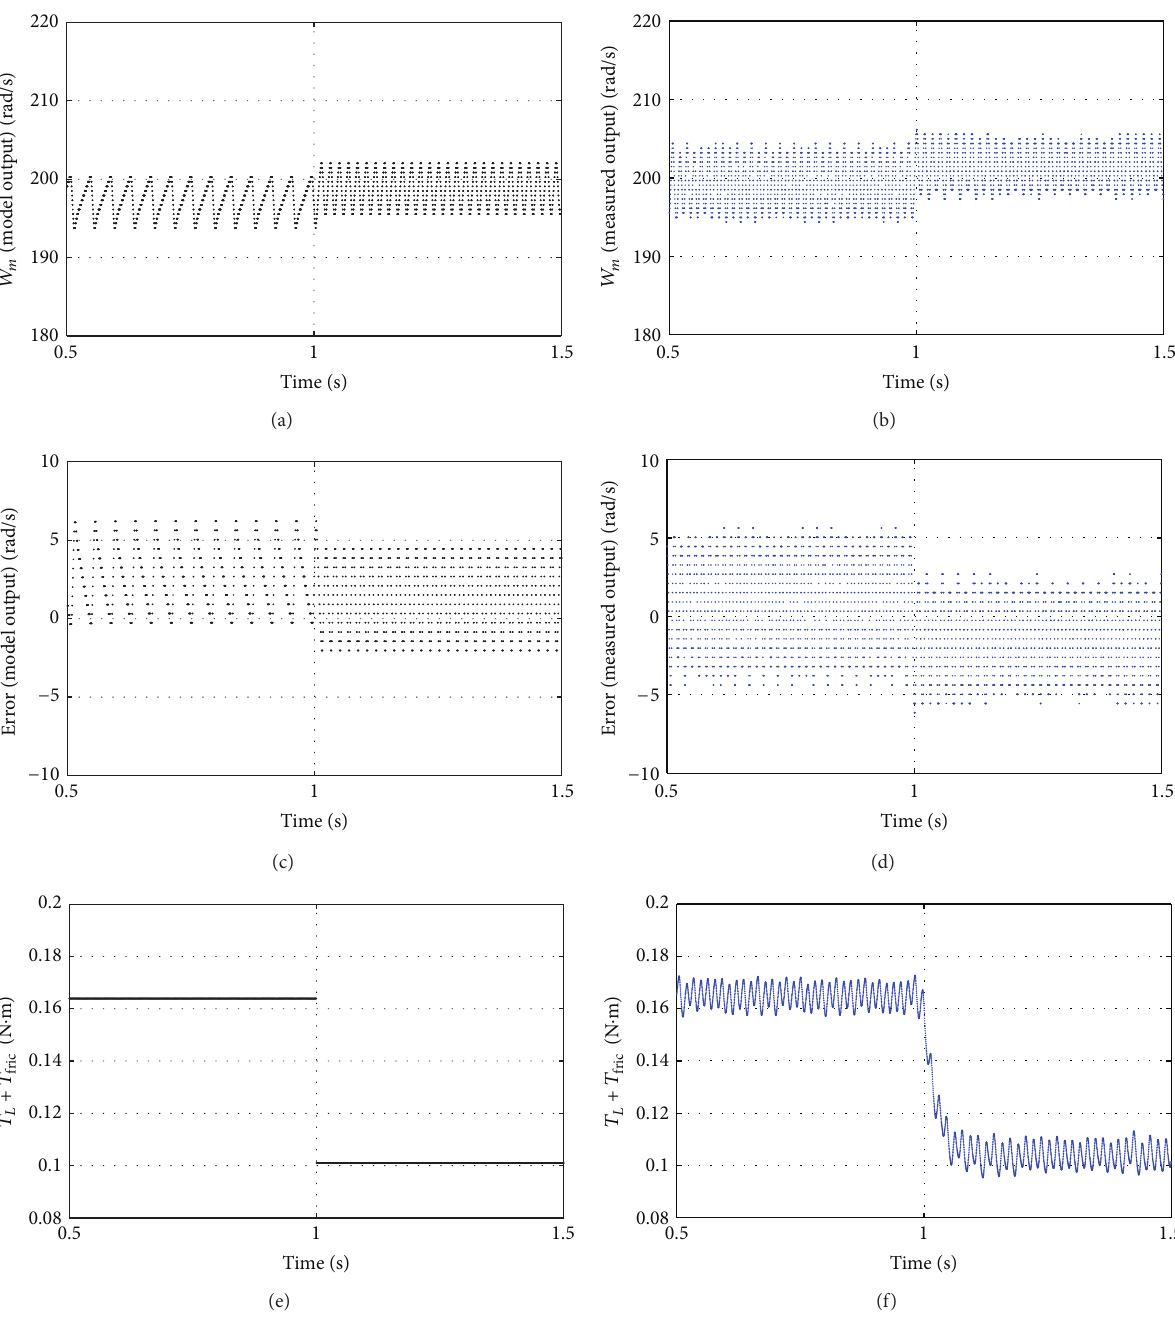
changes from 0.1639 N ⋅ m to 0.101 N ⋅ m at 𝑡 = 1 s. (a), (c), (e) fric